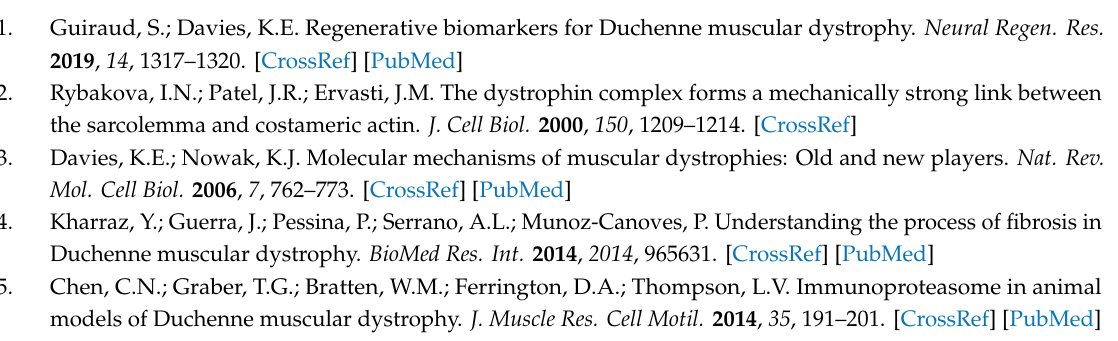
Figure S1: Representative image of total proteins from the gastrocnemius muscles (enriched proteasome preparation)., Figure S2: The content of α 7, LMP2, and LMP7 in WT-V and WT-O